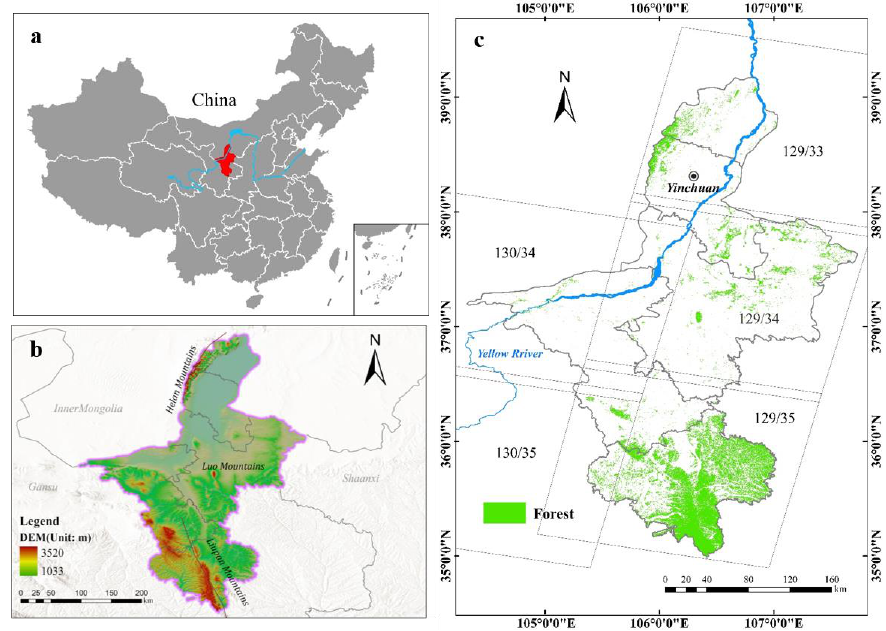
Figure 1. Location of the study area: ( a ) general location in China; ( b ) digital elevation model (DEM) of the study area; and ( c ) forest area of Ningxia Hui Autonomous Region in 2020.